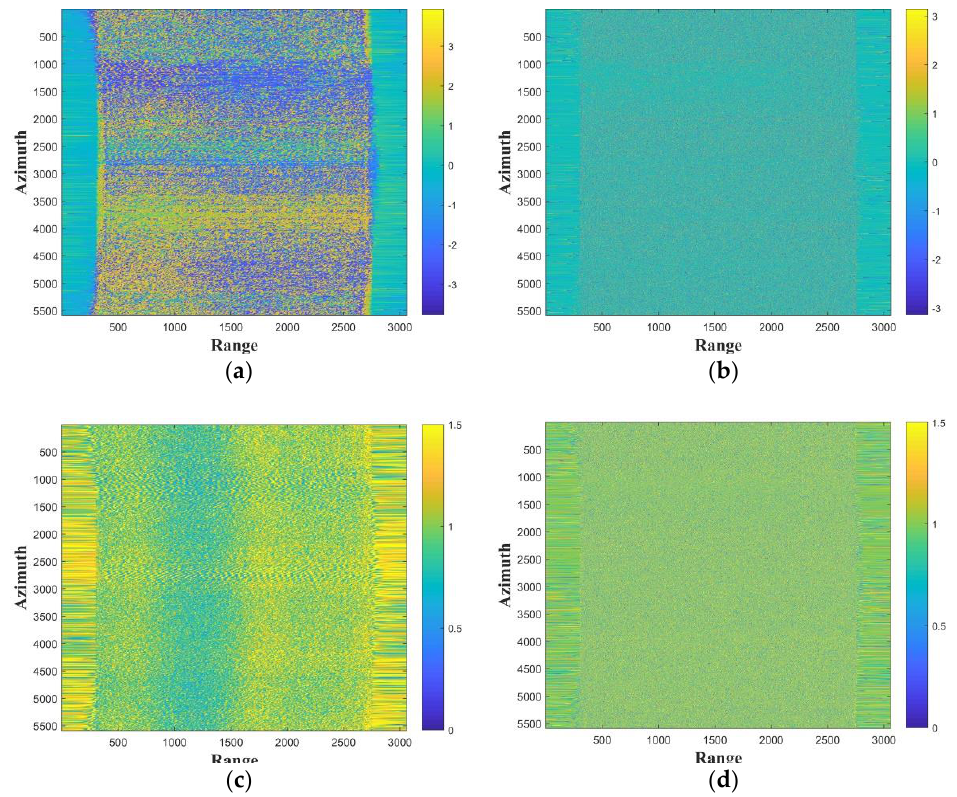
Figure 11. Channel errors’ characteristics and compensation results. ( a ) Phase error between channels #1 and #2. ( b ) Phase error after compensation. ( c ) Amplitude ratio of channel #2 relative to #1. ( d ) Amplitude ratio after calibration.